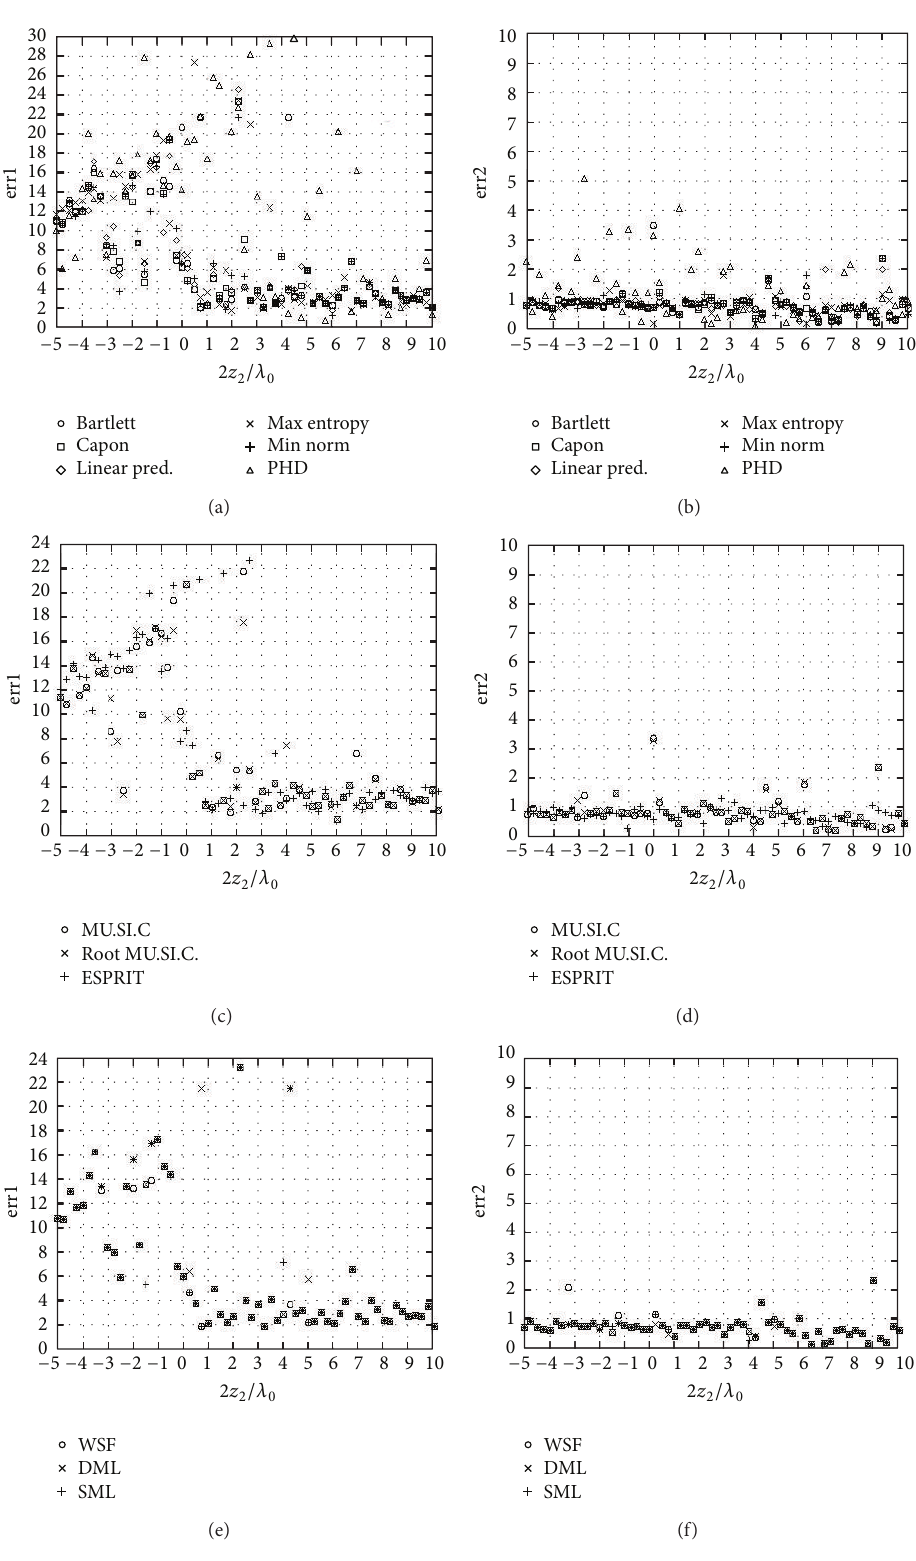
Figure 4: Same as in Figures 2 and 3, for two dielectric cylinders with 𝜀 𝑟1 = 𝜀 𝑟2 = 9